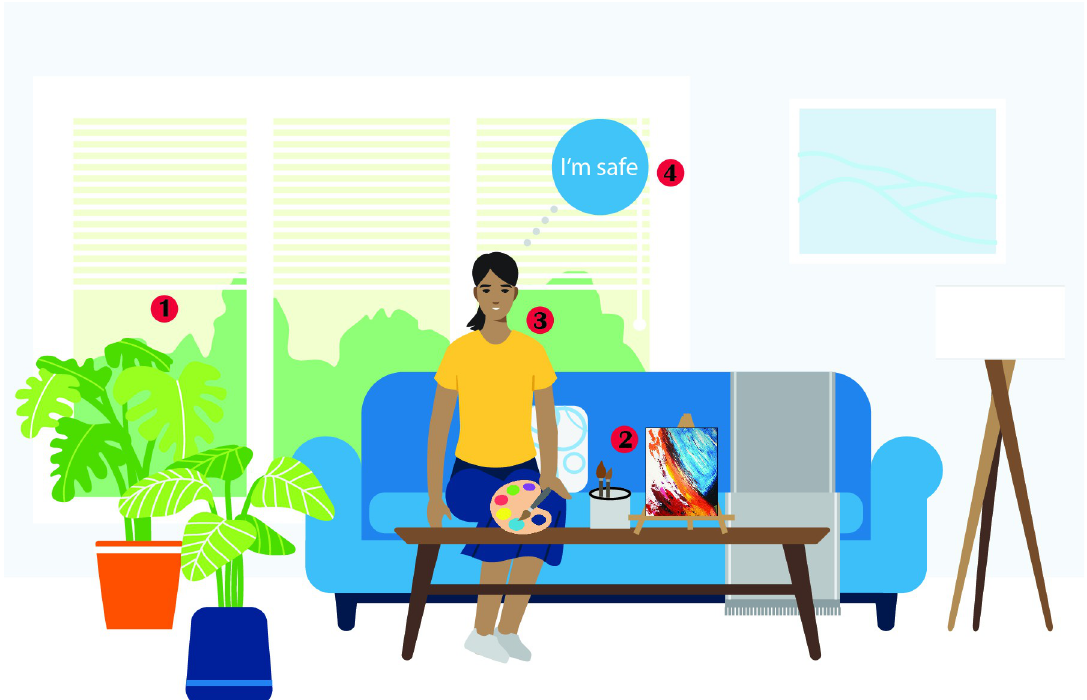
Fig 2. Key themes. A depiction of a hypothetical mental health recovery space that integrates key themes in this study, including 1) sensory design elements (for example, the presence of natural light and plants as a reminder of nature), 2) engagement intensity (engaging in a creative activity like painting), 3) social relational aspects (privacy and personal space), and 4) affective experiences (feeling of